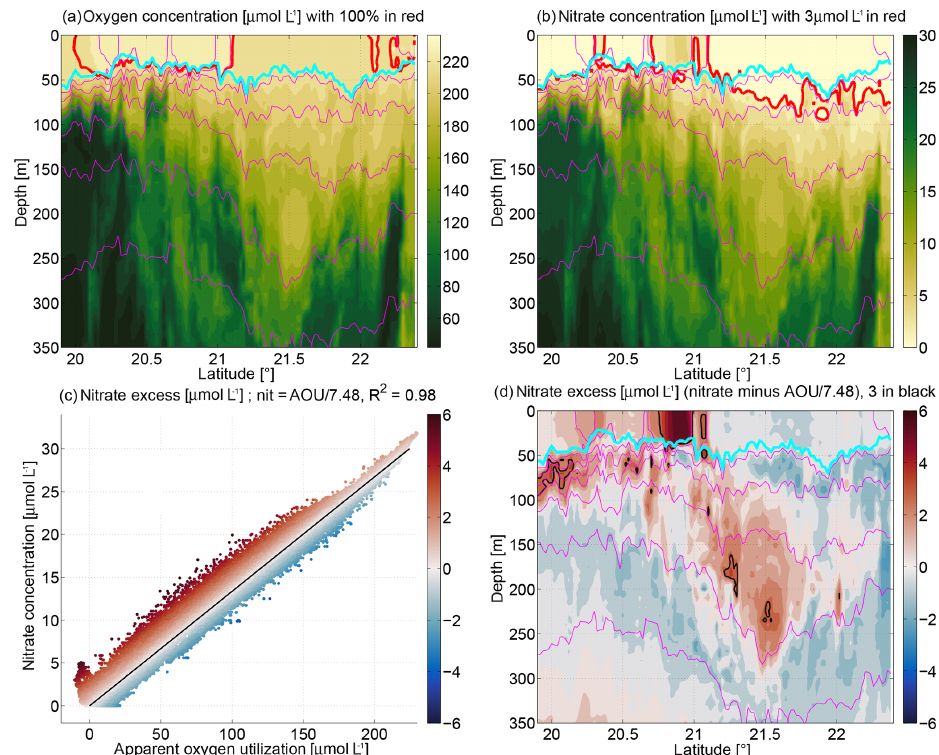
Figure 7. Sections of (a) oxygen concentration (in micromoles per liter), (b) nitrate concentration (in micromoles per liter), and (d) ni- trate excess (in micromoles per liter). Highlighted are the following contours: (a) 100% oxygen in red, (b) 3µmolL − 1 nitrate in red, and (d) 3µmolL − 1 nitrate excess in black. (c) All data in scatter plot of apparent oxygen utilization versus nitrate concentration where the black line is a best-fit linear regression, with nitrate = AOU/7.48. A nitrate excess of zero is on the black line in (c) ; positive/negative nitrate excess is colored red/blue above/below the black line in (c)